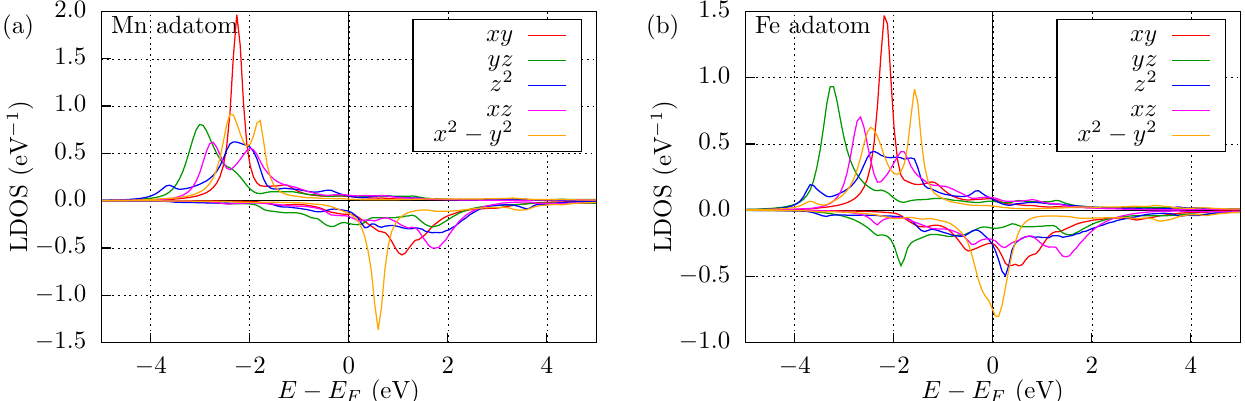
Figure 2. Local density of states of magnetic adatoms. Spin-resolved LDOS of the ( a ) Mn (cf. the work in [7]) and of the ( b ) Fe adatoms as projected onto the d orbitals. Positive values: LDOS of majority spin channel; negative values: LDOS of minority spin channel multiplied by 1. The Fermi energy is denoted by a vertical black line at E = −